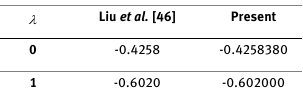
Table 3: Temperature gradient- θ (cid:48) (0) for distinct values of λ when Pr = 0.7